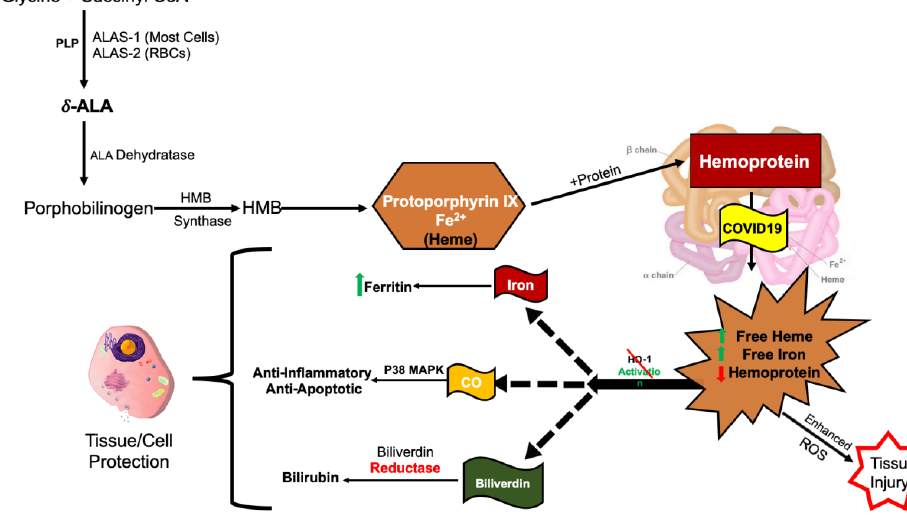
Figure 4. The porphyrin synthesis pathway in relation to COVID-19. The porphyrin synthesis pathway displaying COVID-19 binding the end product, hemoprotein, which binds non-enzymatically to porphyrin causing upregulation of heme production as a result of negative feedback due to a decrease in functional hemoprotein. This leads to increased free heme, decreased functional hemoprotein, and the release of toxic iron, resulting in tissue injury. Key: CoA = coenzyme A, ALA = delta-aminolevulinic acid, and HMB =